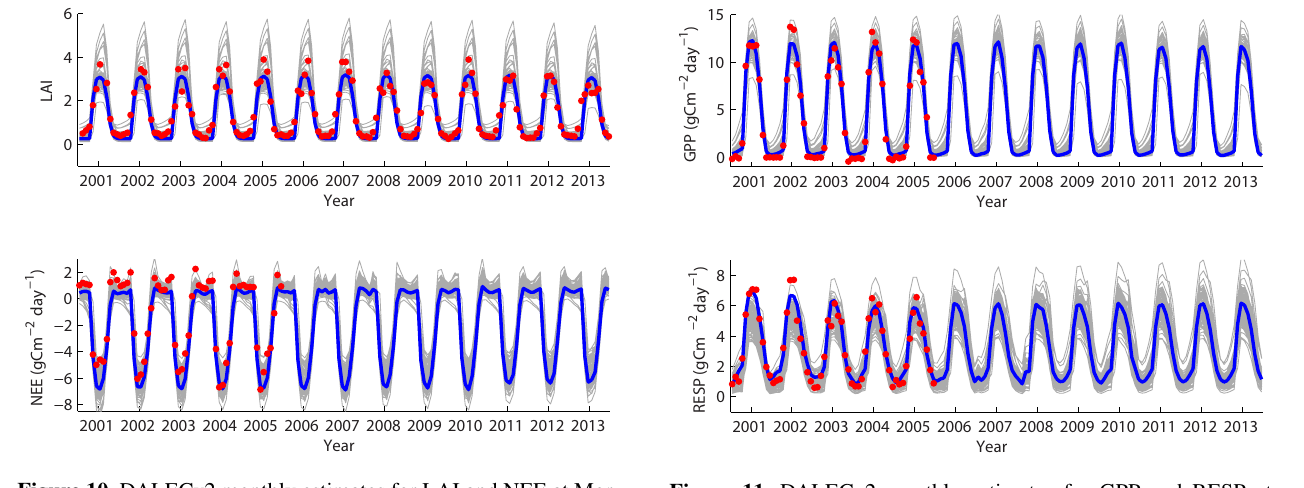
Figure 11. DALECv2 monthly estimates for GPP and RESP at Morgan Monroe State Forest. The red dots are the observations, the blue trajectories are obtained using the 4DVAR analysis, the grey trajectories are ensemble runs obtained from a 95% confidence sample of the posterior